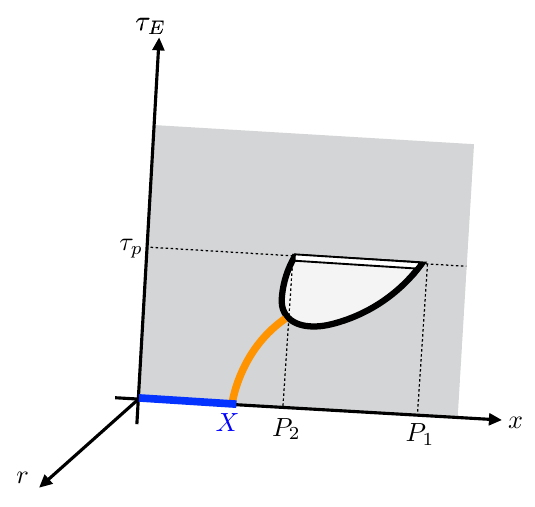
Figure 11 . Euclidean geometry for computing the minimal area surface in section 5.2. We omit the lower half of the Euclidean geometry ( τ 0 part) as the geometry is time-reflection E <